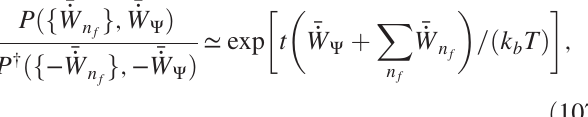
− V ). (c) Logical symbol for ss ¼ dd